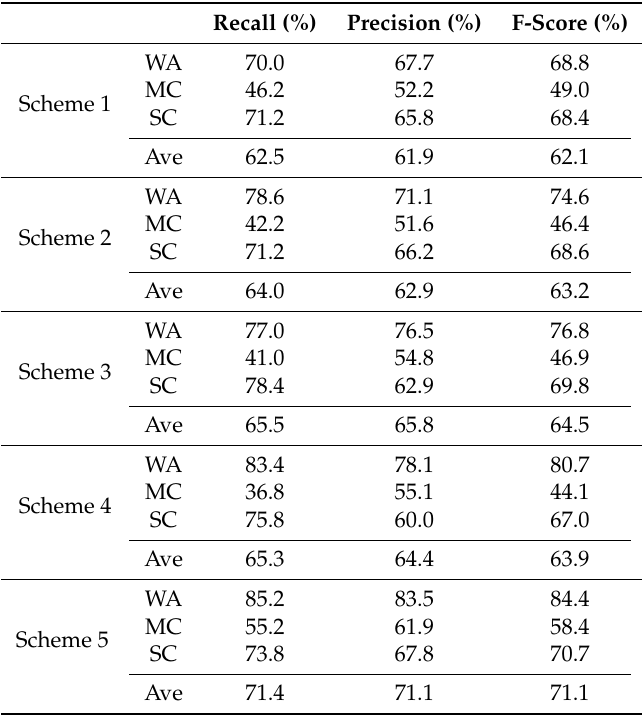
Figure 10. Mapping result of Scheme 5: ( a ) ground truth data; and ( b ) mapping result. Table 7. Accuracy evaluation of three-class